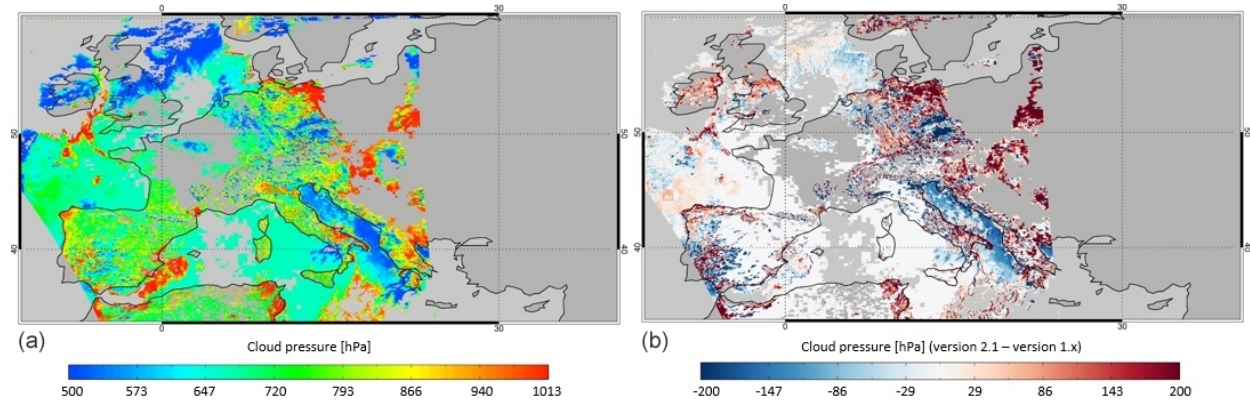
Figure 14. ROCINN_CRB cloud pressures from the version 2.1 processor (a) and comparisons with version 1.x (b) over Europe for orbit 6939 on 14 February 2019. Only measurements with 0 < cloud fraction < = 0 . 4 are included.